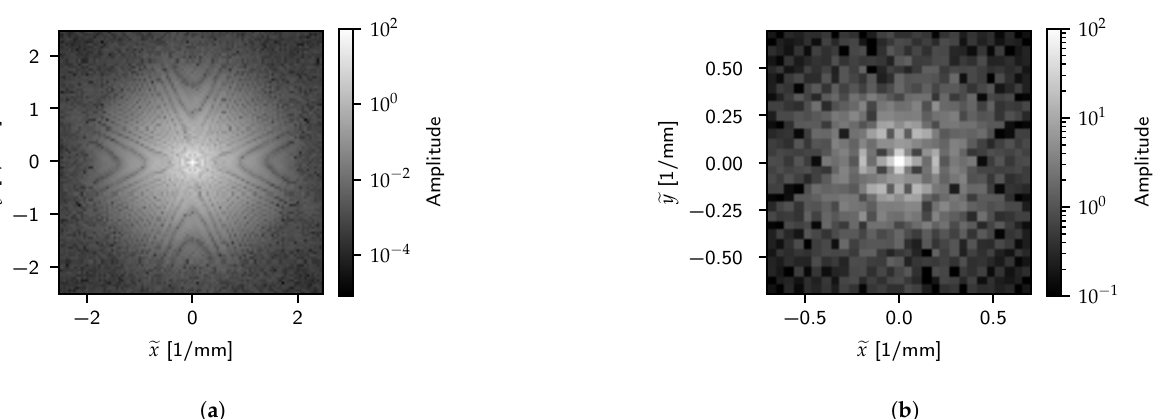
Figure 19. FFT of color gradient magnitude for the cylindrical case over ( a ) the total frequency domain and ( b ) a low-frequency domain.